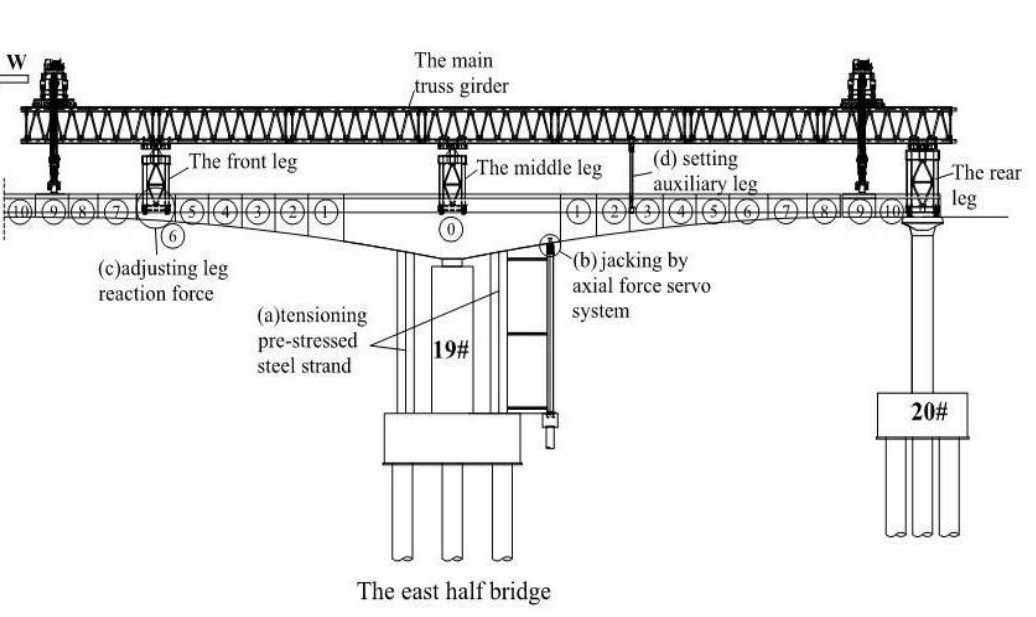
Figure 2. Cross section of the bridge.